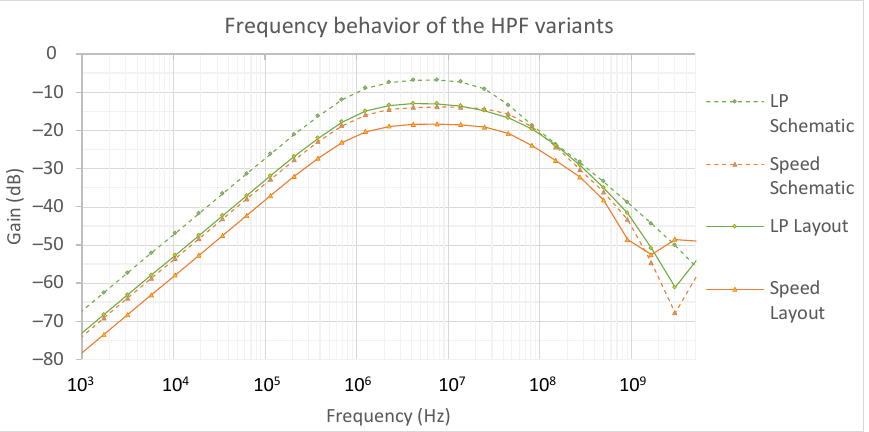
Figure 12. Frequency behavior of the HPF variants when using the amplifier variants “LP” and “Speed”. Each variant was simulated both on schematic level and post-layout. It can be seen that the speed variant produces less gain but achieves a higher upper corner frequency. After extraction, about 5.7 dB and about 4.3 dB gain is reduced for variant “LP” and variant “Speed”, respectively. Table 2. Comparison of schematic-level and post-layout simulations of the HPF variants.